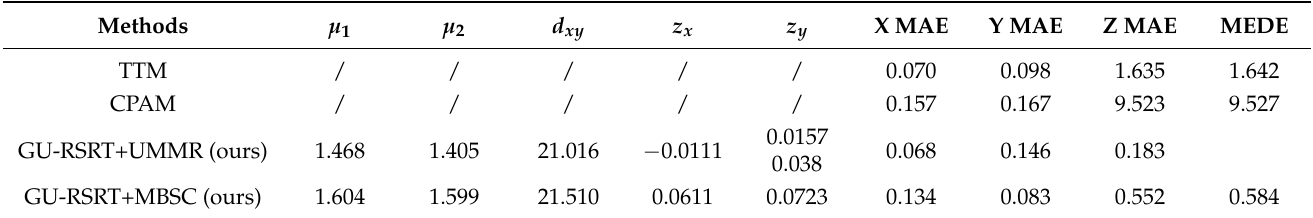
Table 4. The calibration results and 3D reconstruction errors of the GelStereo Tip sensor. The unit of d xy , X MAE, Y MAE, Z MAE, and MEDE is mm.